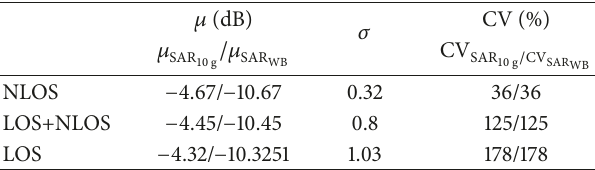
Table 4: Characteristic of the distribution of exposure values at 1940